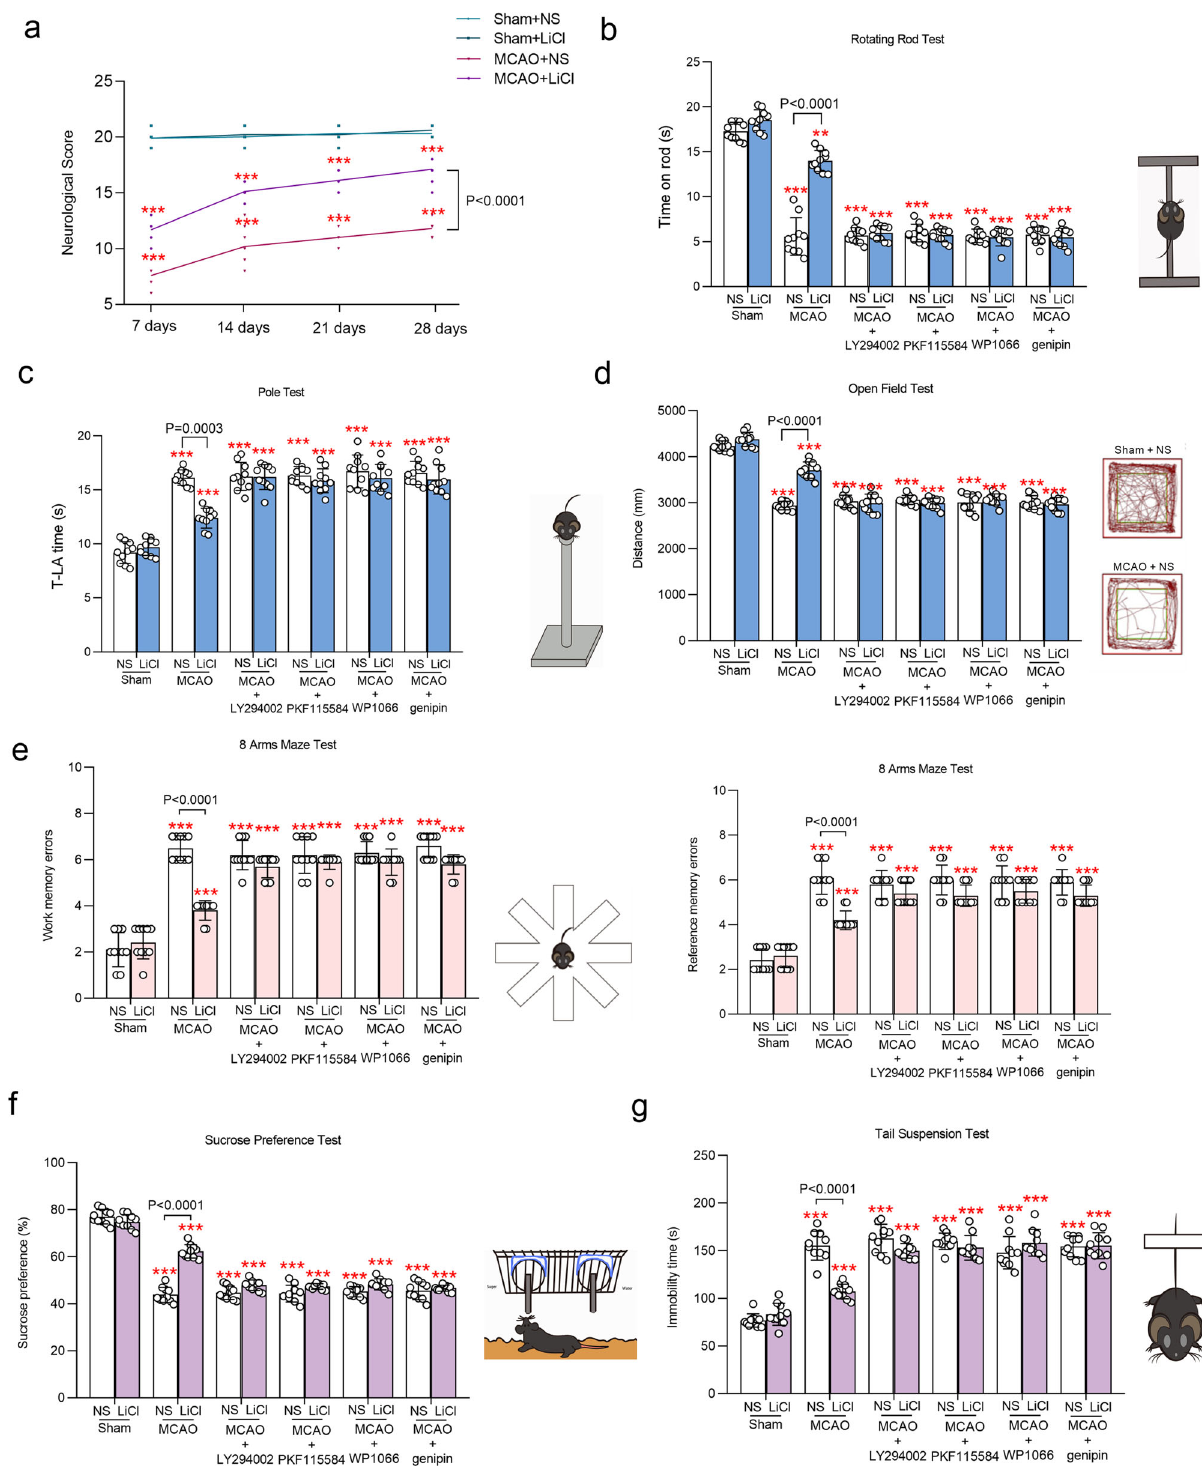
Fig. 8 Behavioural effects of LiCl. a The neurological scores measured at 7, 14, 21 and 28 days. b The staying time on rod measured by rotating-rod test. c T-LA time measured by Pole test. d The move distance was recorded in open- fi eld test. e The work memory errors and reference memory errors were calculated in 8-arms maze test. f The sucrose preference percentage were measured by sucrose preference test. g The immobility time were recorded in tail-suspension test. The neurological score and the evaluated behavioural indicators were calculated and plotted as mean ± SD. N = 10 per group. Two-way ANOVA for comparisons including more than two groups; unpaired two-tailed t -test for two group comparisons. * p < 0.05, ** p < 0.01, *** p <